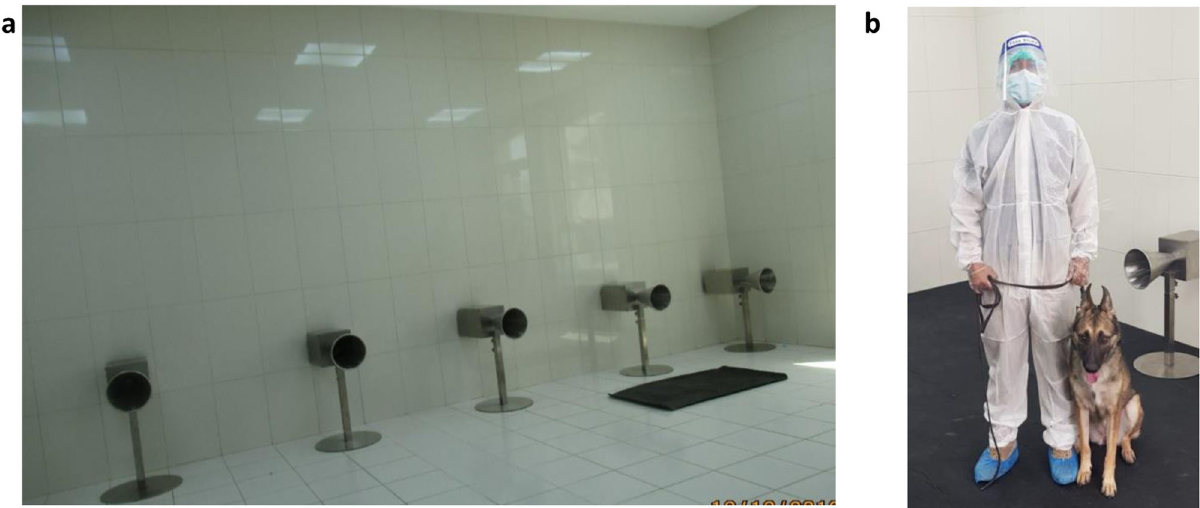
Fig. 2 Training stations lined up at the Federal Customs Authority (FCA) facilities in Abu Dhabi, United Arab Emirates, for the training of explosives detection dogs. a Training devices with samples ’ containers placed right behind the metal olfaction cones. b The dog handler is deployed to work with the dog as a